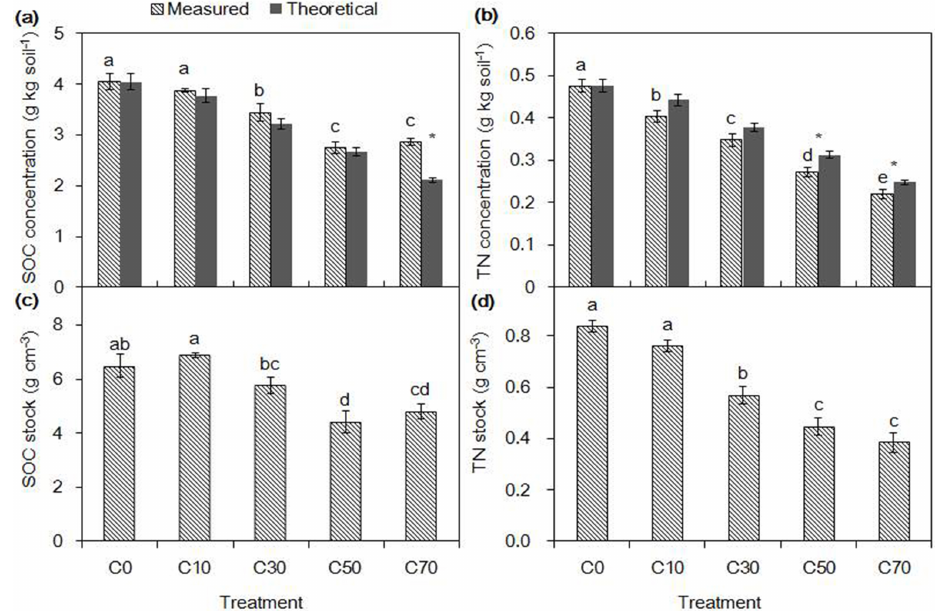
Figure 3. Soil organic carbon (SOC) and total nitrogen (TN) concentrations ( a and b , respectively) and stocks ( c and d , respectively) as affected by different degrees of soil coarseness: 0% sand addition (C0), 10 (C10), 30 (C30), 50 (C50), and 70% (C70). Dashed bars represent values obtained from laboratory measurements, while black bars are values calculated from theoretical dilution. Data represent mean ± standard error ( n = 6). Letters indicate significant differences among treatments. Asterisks indicate significance between values from laboratory measurements and theoretical values accounting for dilution within one